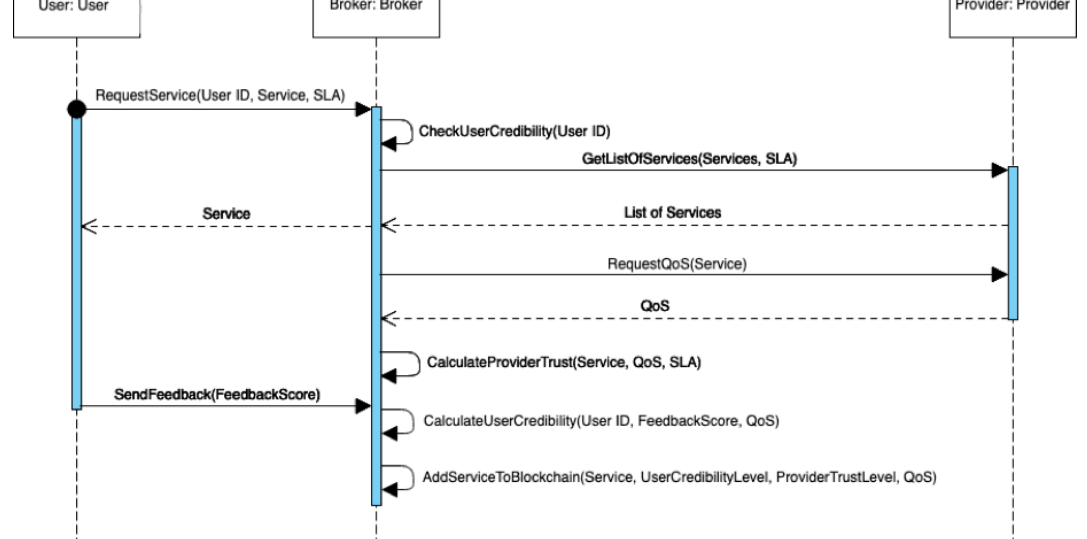
Figure 5. Interactions between the users and HealthyBroker